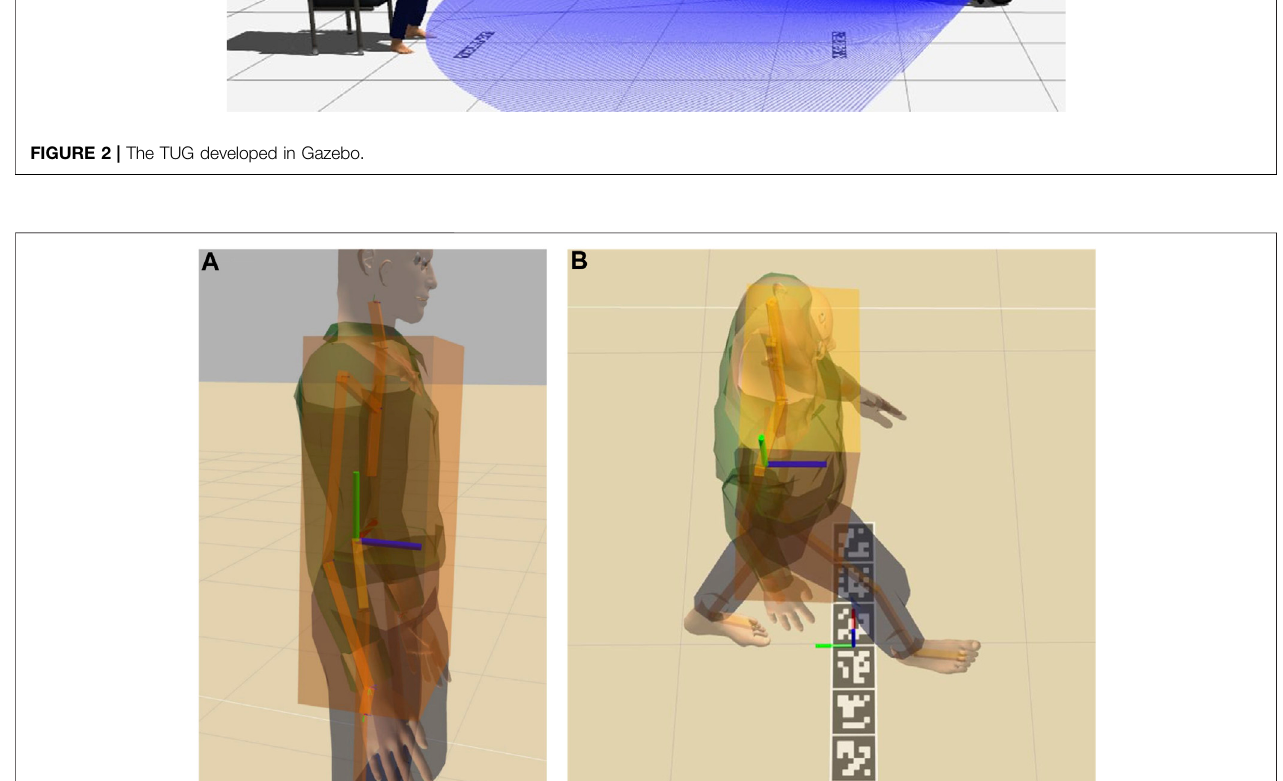
FIGURE3| The Actor withtheboundingboxaroundthetorsoandthelowerspinekeypoint (A) andthe Actor walkingcomparedtothe fi nishlineframe (B) .Red green and blue axes represent x, y and z respectively.